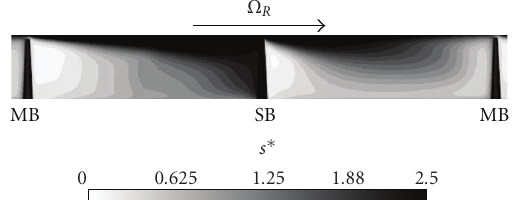
Figure 9: Reduced and time-averaged entropy at impeller